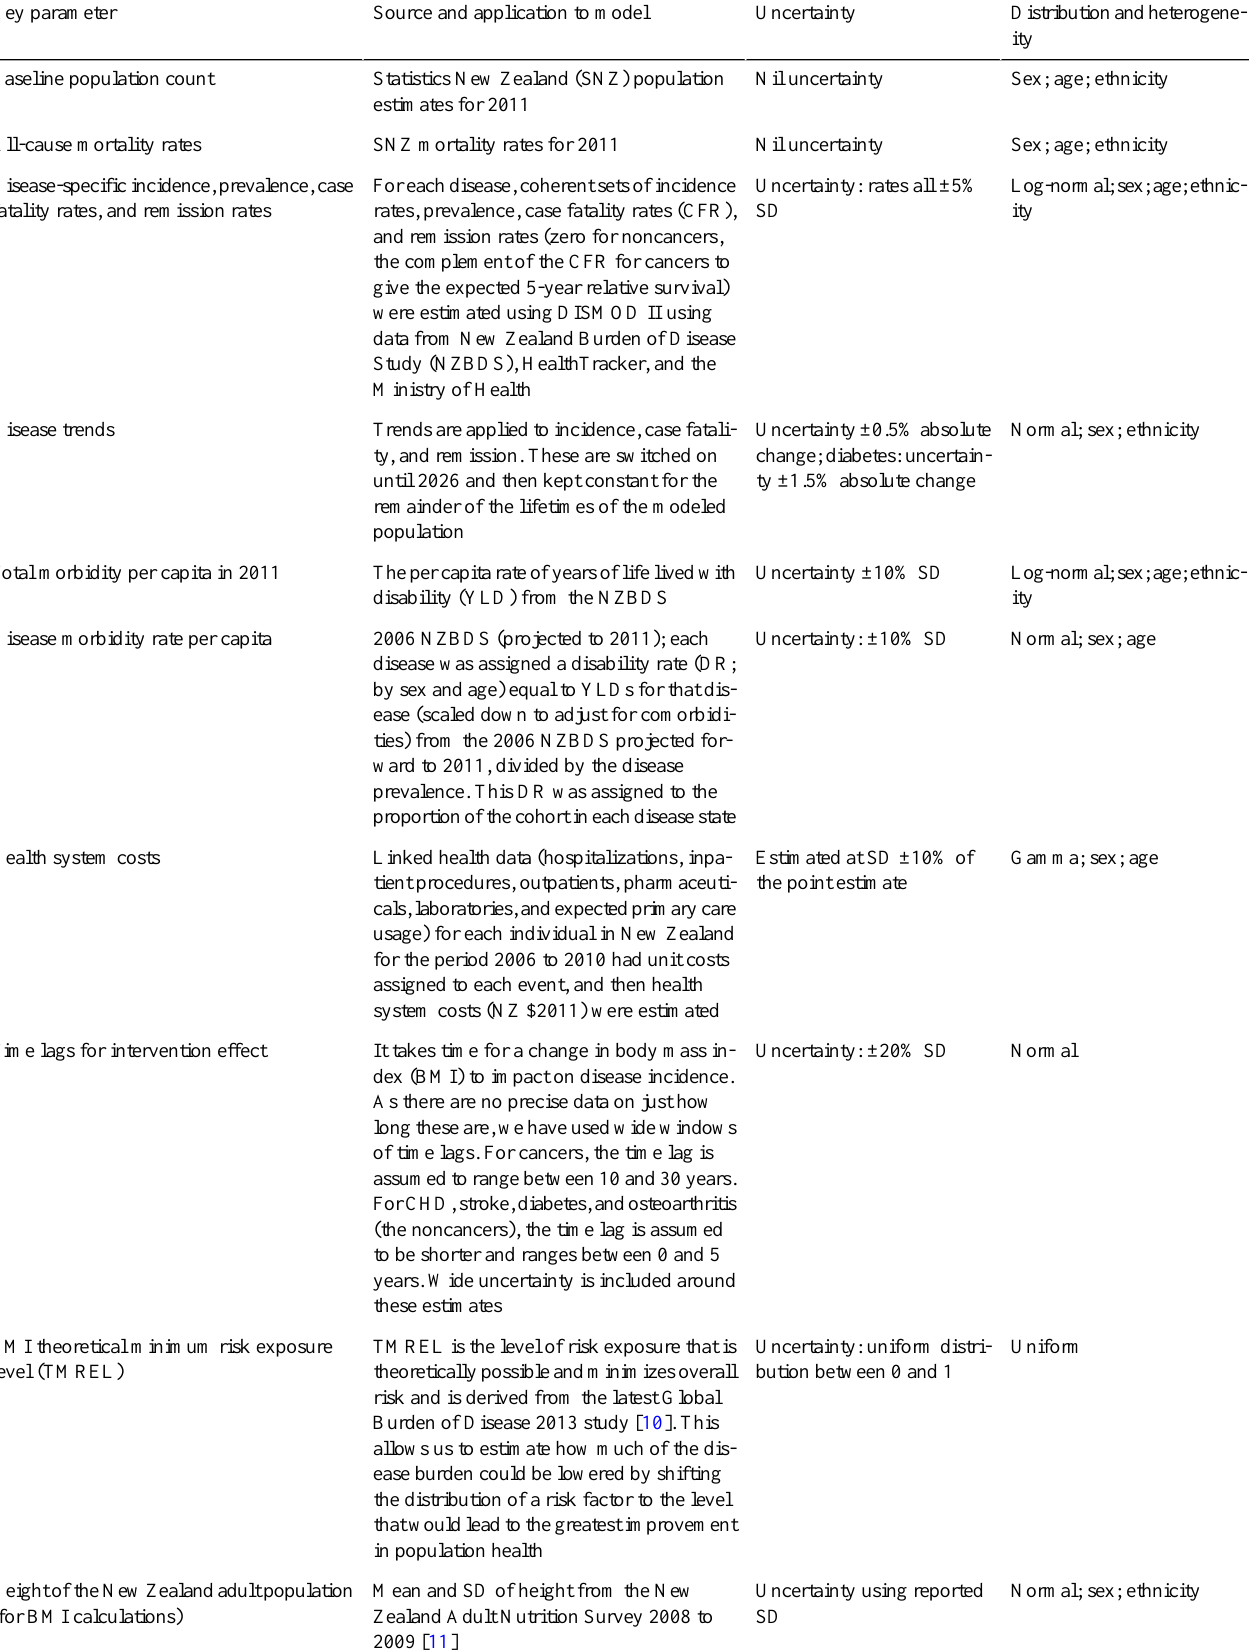
Table 1. Baseline input parameters used in modeling the promotion of smartphone apps for weight loss.